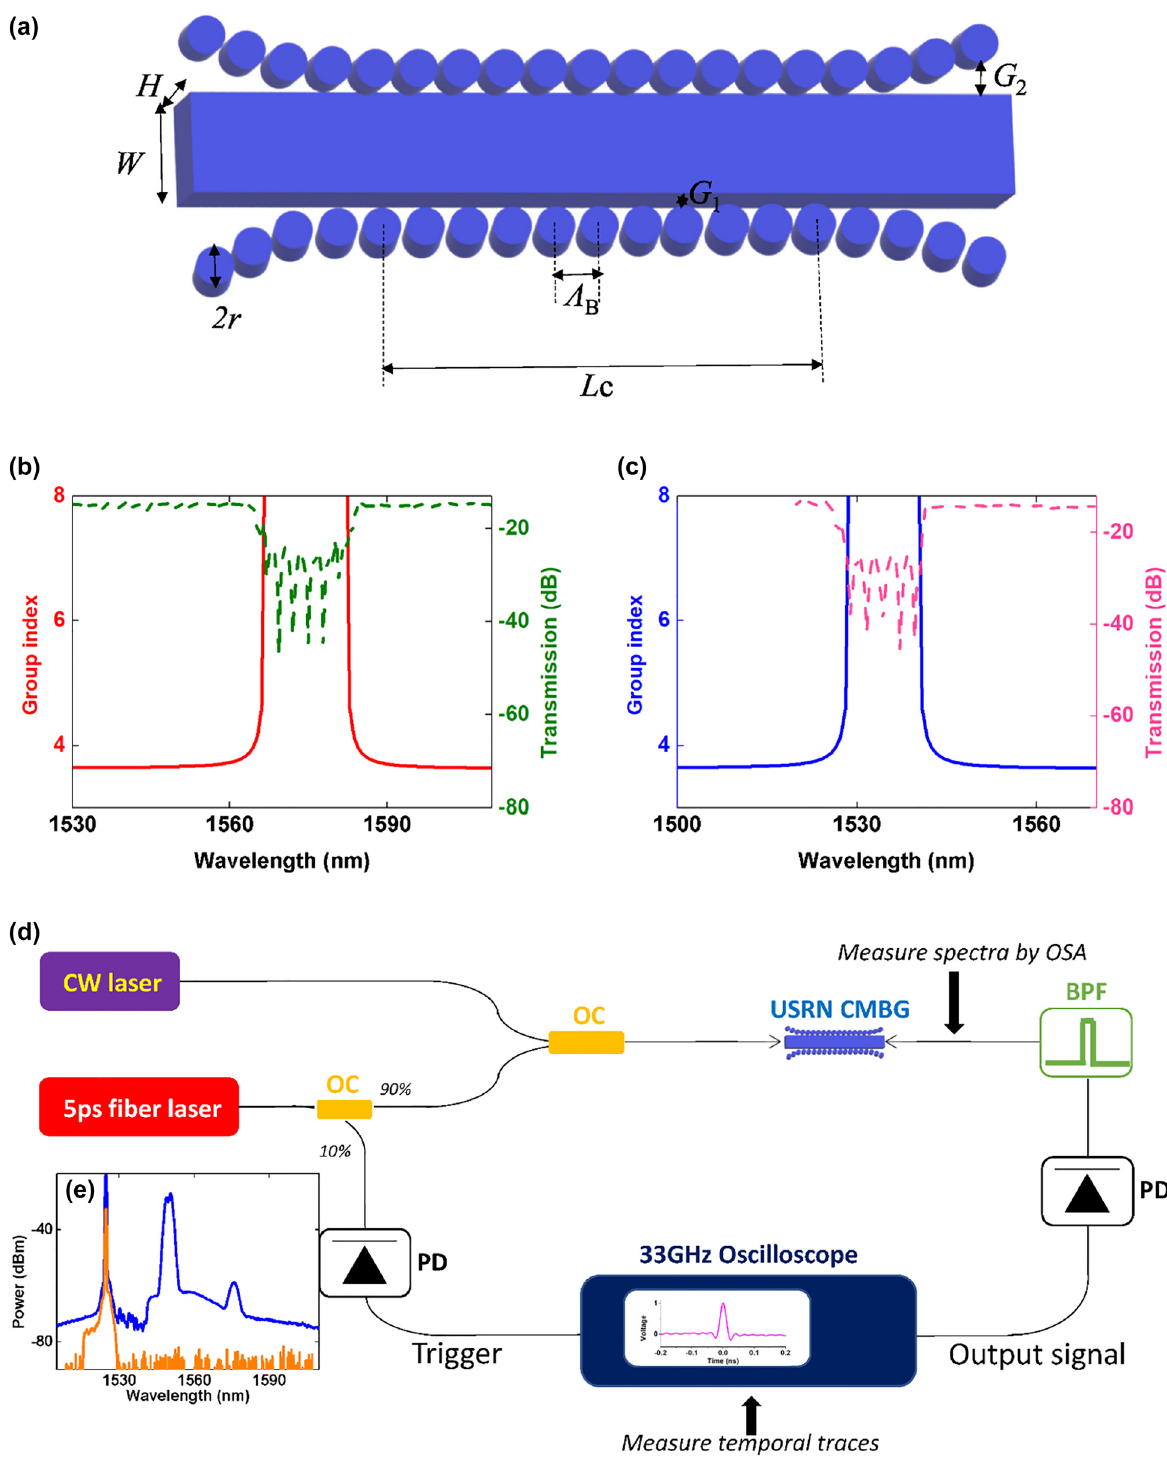
Figure 2: (a) The schematic the grating used and linear transmission spectra and group index properties for the nonlinear gratings used in (b) Configuration 1 and (c) Configuration 2. (d) The experimental setup for temporal and spectral measurements. (OC: optical coupler, OSA: opticalspectrumanalyzer,BPF:bandpassfilter,PD:photodetector).(e)TheoutputspectrabeforeBPF(blueline)andafterBPF(orangeline)for Configuration